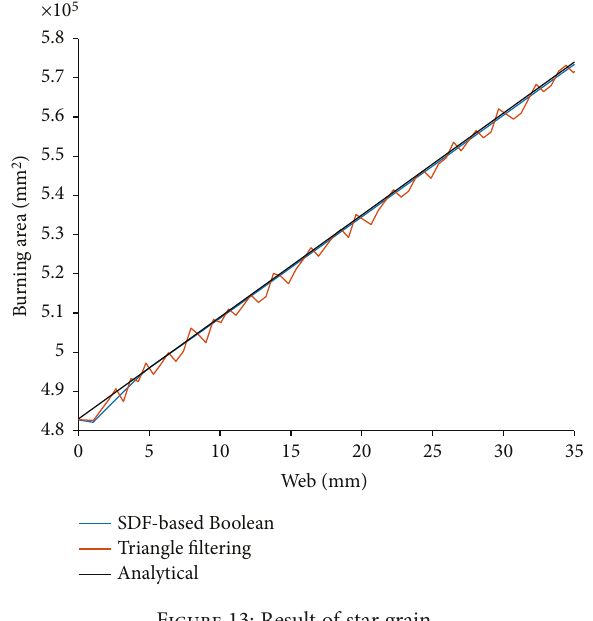
Figure 13: Result of star grain. Table 5: Comparison between CPU and GPU execution time (per call). CPU, Intel i54570; GPU, NVIDIA K2200.